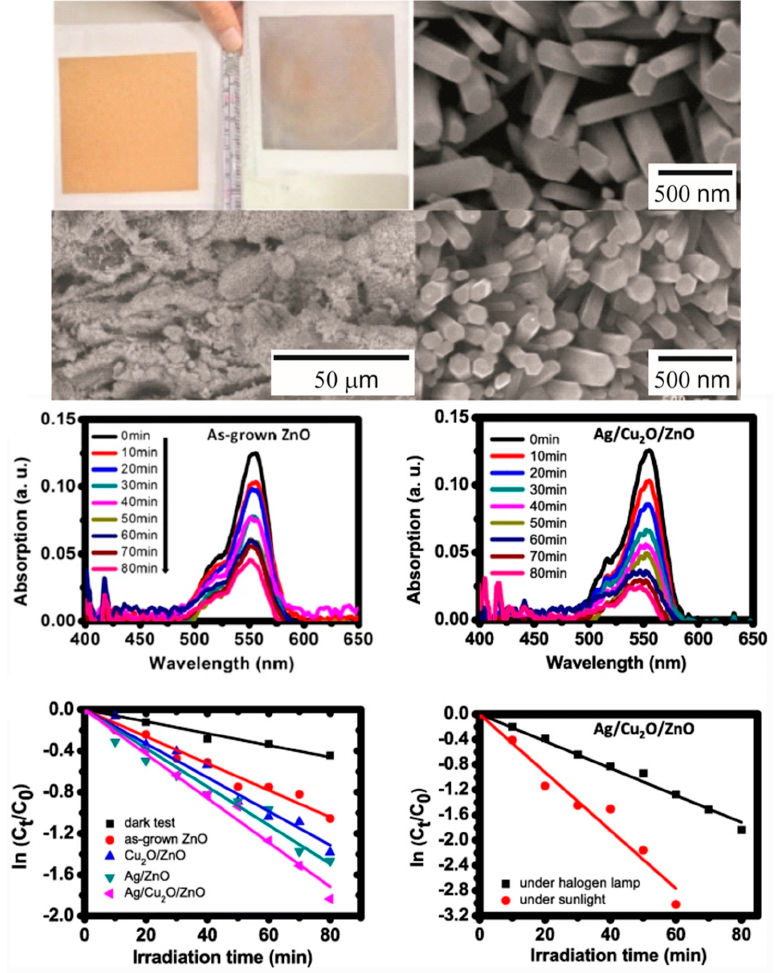
Figure 13. Real photographs of the kraft paper substrate and the paper with the ZnO nanorods. The SEM image of the papers containing the ZnO nanorods are presented together with their photocatalytic activity under visible light [54] . Reproduced with permission of Springer Nature [54] .